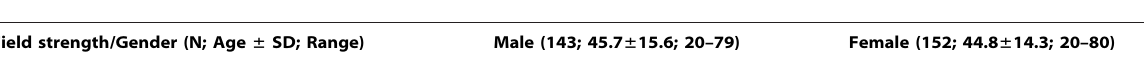
Field strength/Gender (N; Age ± SD; Range)